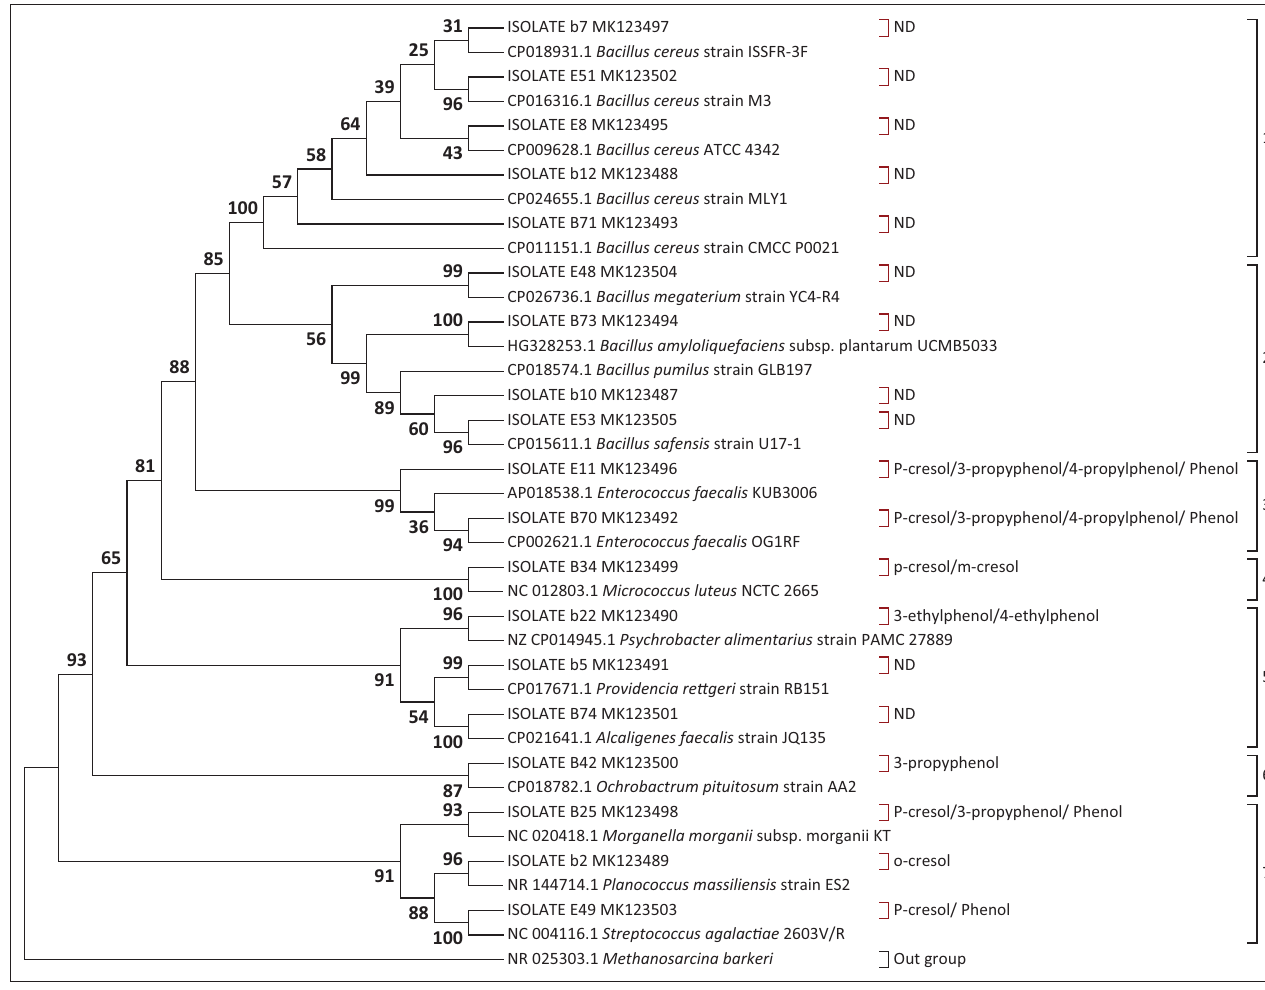
FIGURE 2: Molecular phylogenetic analysis of bacterial communities with and without the potential to mediate production of phenols in mammalian urine by the maximum likelihood method.